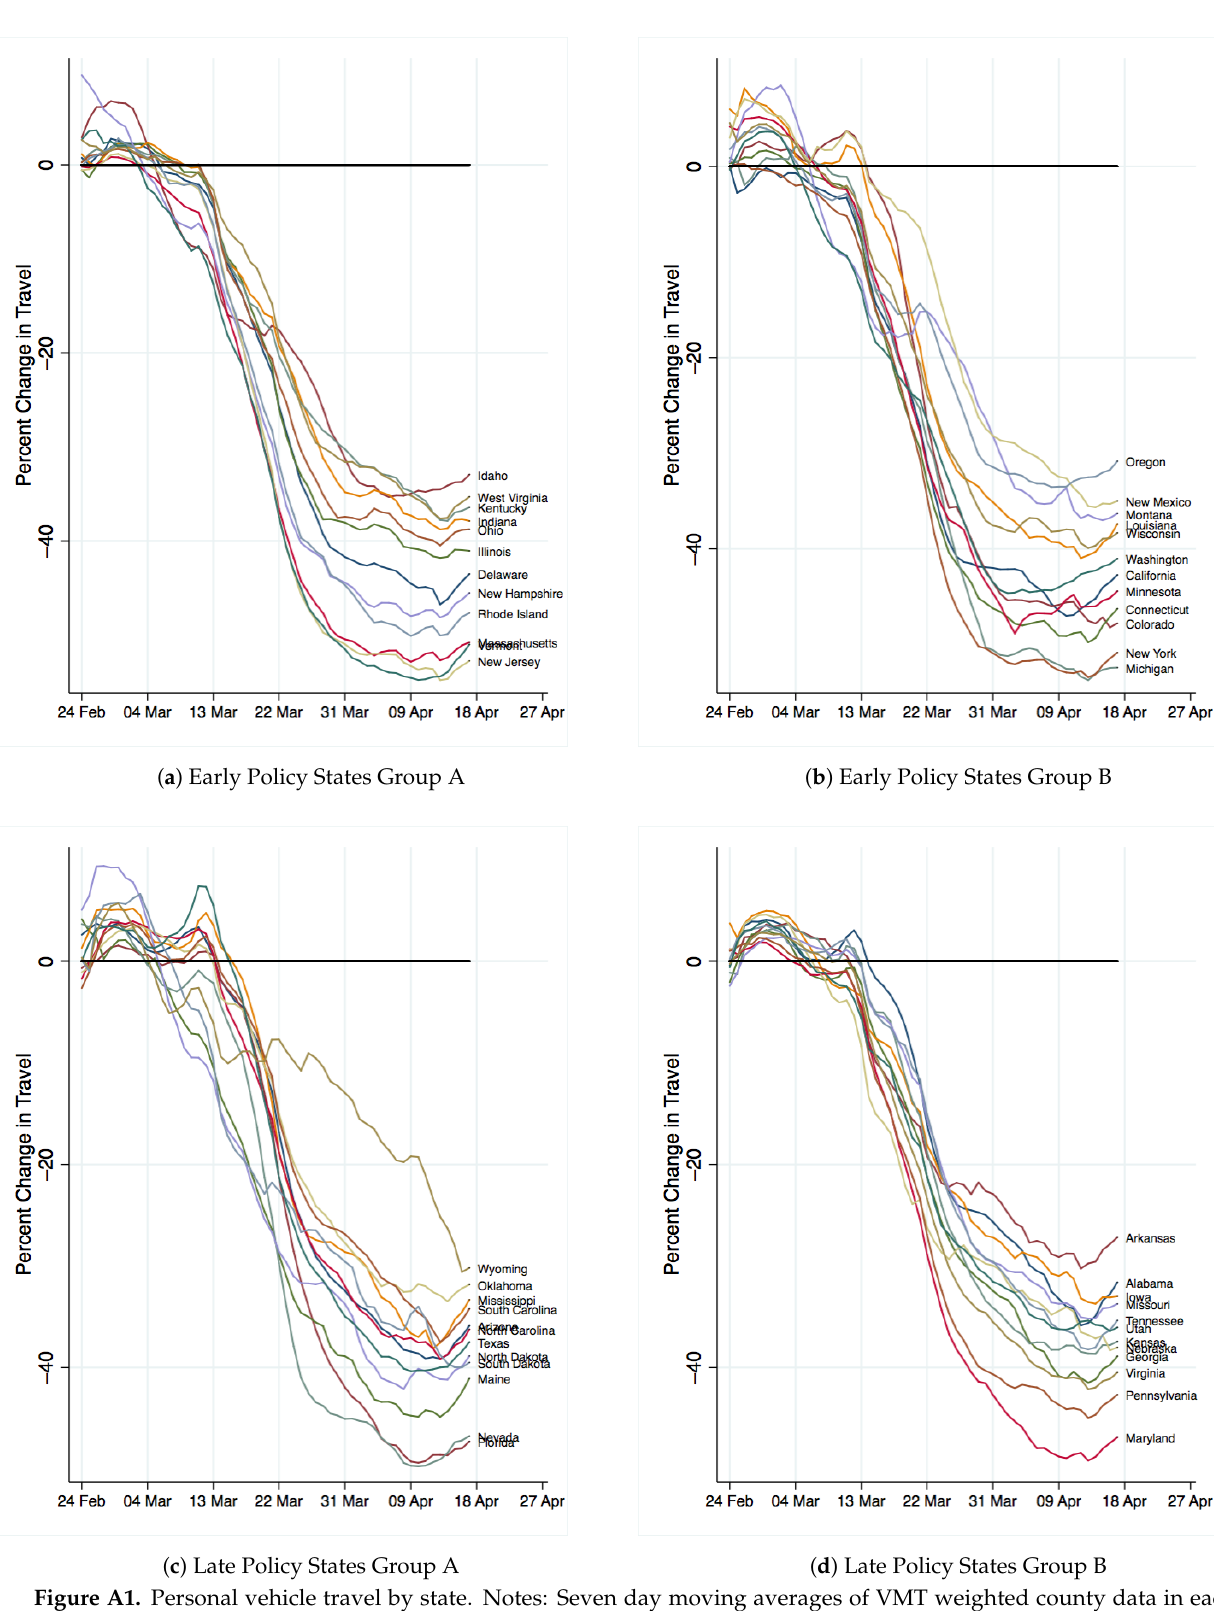
Figure A1. Personal vehicle travel by state. Notes: Seven day moving averages of VMT weighted county data in each state [26]. Early policy states put a stay-at-home policy in place by 28 March 2020. Groups A and B distinction is